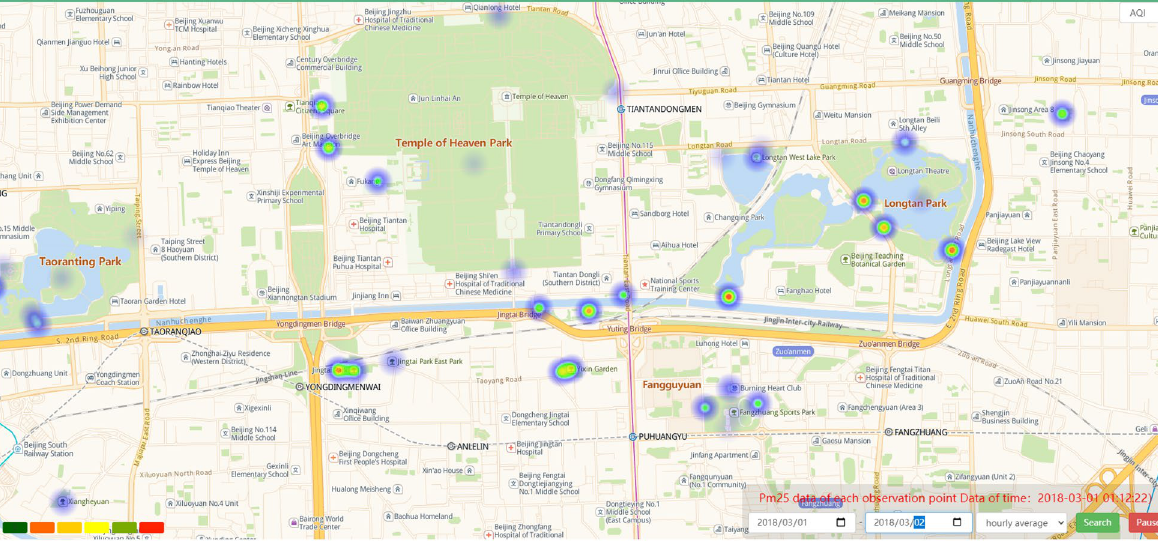
Figure 3. Because of the AQI, PM2.5, PM10, SO 2 , NO 2 , CO, different observation parameters such as O 3 change trend in different periods to heat (From: Bai du map).